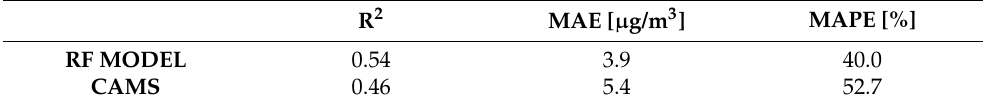
Table 4. Comparison of RF and CAMS ensemble median models’